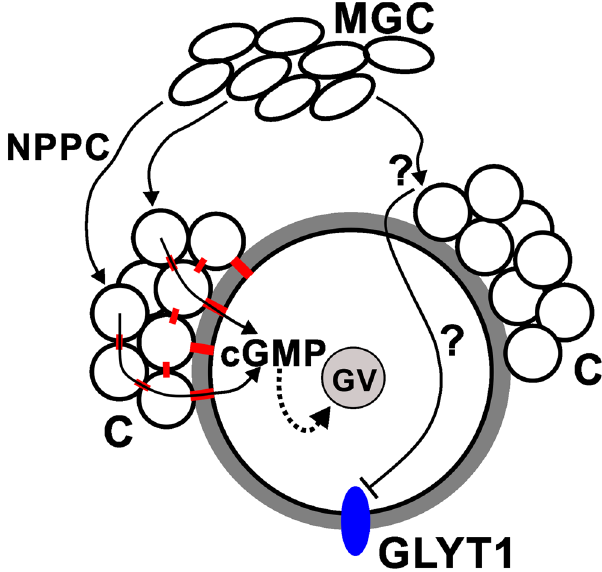
Figure 5. Schematic model. It is well-established that MGC secrete NPPC that binds to its receptor on cumulus cells (C) which then produce cGMP that diffuses into the oocyte via gap junctions (red) between the cumulus cells and between cumulus and oocyte. The cGMP then maintains meiotic arrest by inhibiting PDE3 so cAMP remains elevated (represented by dotted line). We have shown here that, in contrast, the NPPC/cGMP signalling pathway is not sufficient to suppress the development of GLYT1 activity. Instead, we hypothesize that MGC produce an unknown factor (?) that could either act directly on the oocyte or indirectly via cumulus cells, but does not require gap